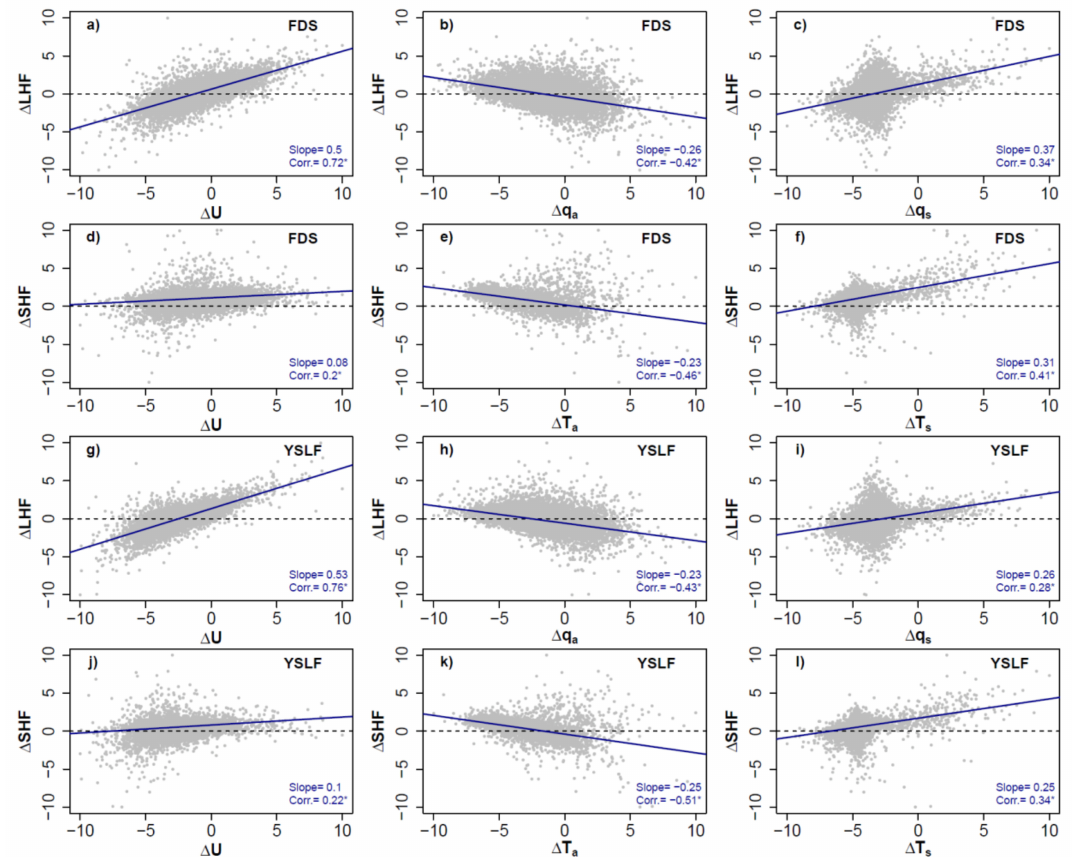
Figure 9. Latent (LHF) and sensible (SHF) heat flux residual dependency for each bulk component. Residual data were normalized to the range of − 10 to 10. The slope of the linear fit and correlation values (star marks show statistically significant value at 95% level) are included in the bottom right of each respective plot. Flux di ff erences (CYGNSS–buoy) for ( a – c ) LHF FDS, ( d – f ) LHF YSLF, ( g – i ) SHF FDS and ( j – l ) SHF YSLF and how they all vary with wind ( ∆ U ). Specific humidity at 10-meters ( ∆ q a ) and surface ( ∆ q s ) is shown for LHF and temperature at the surface ( ∆ T a ) and 10-meters ( ∆ T s ) for SHF. The solid line represents the linear